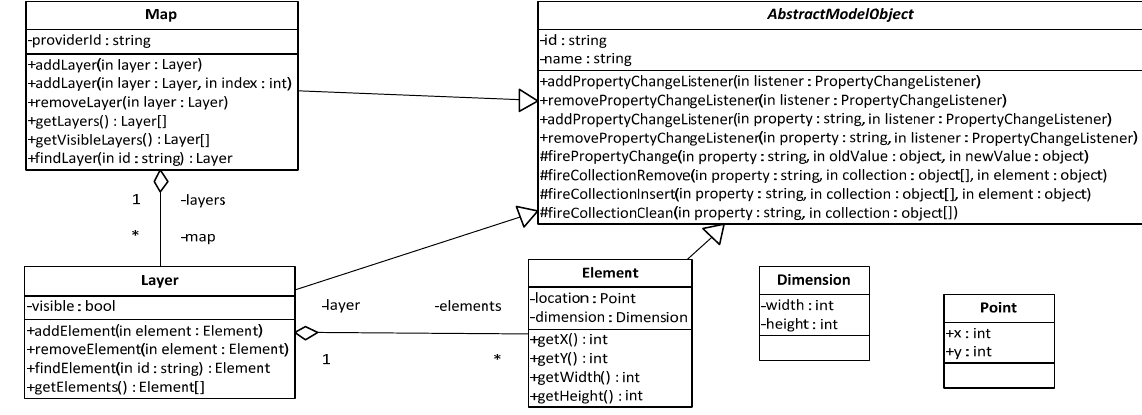
Fig.4. UML diagram of model class structure. NB: some getters and setters of attributes are omitted in order to simplify the